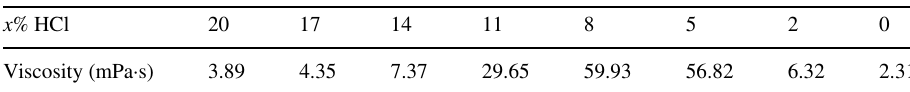
concentration of HCl for viscoelastic surfactants of diverting